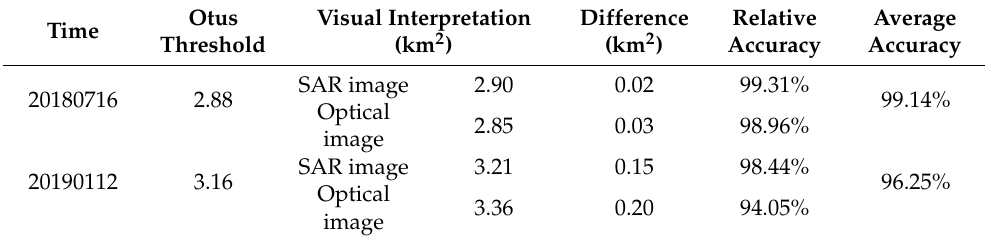
Table 1. The volcano area obtained by different methods.